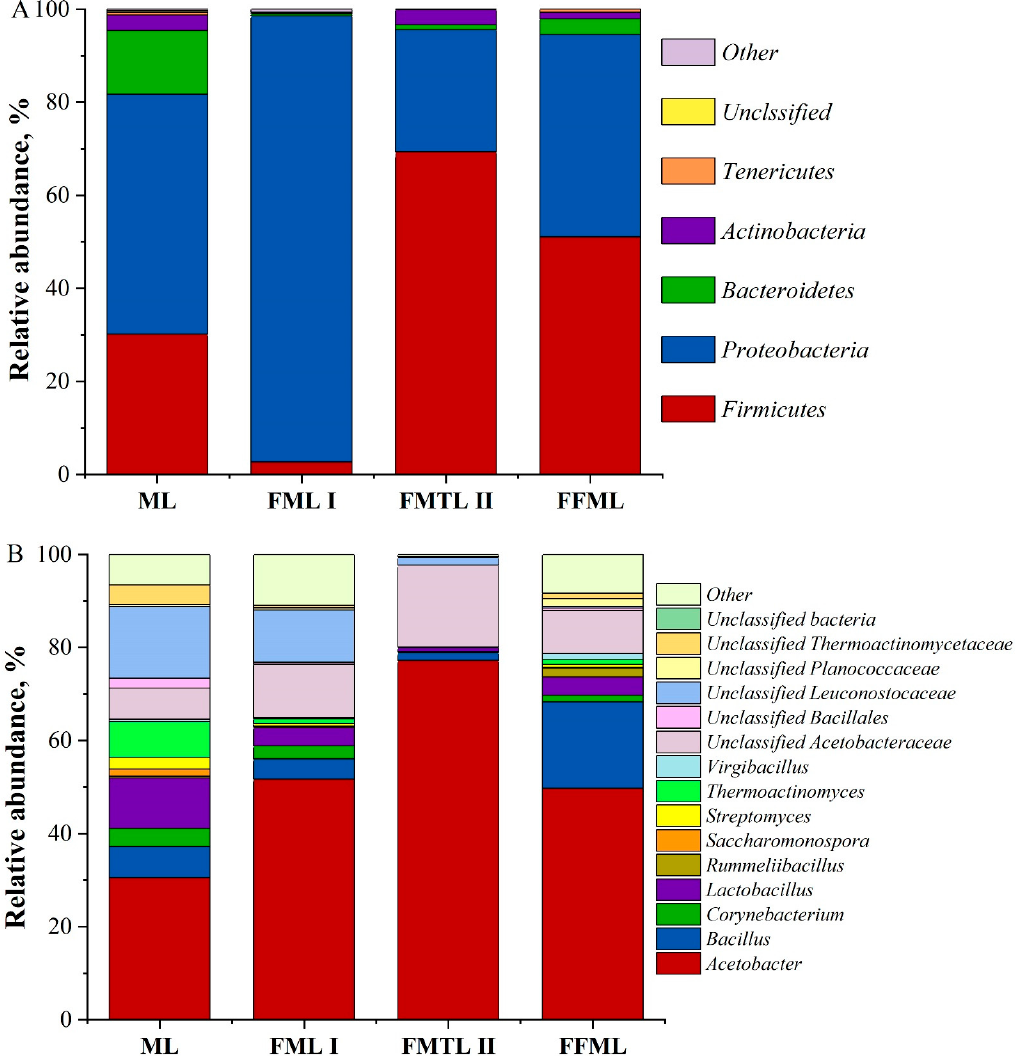
Figure 1. The bacterial composition of Mao-tai lees and fermented Mao-tai lees at the phylum ( A ) and genus ( B ) levels. ML, Mao-tai lees; FML, fermented Mao-tai lees; FML I, FML in the first stage; FML II, FML in the second stage; FFML, FML in the final stage. The bacterial composition of ML and FMLs at the genus level is shown in Figure 1B. The bacterial genera with less than 1.0% relative abundance were excluded from further analysis. Acetobacter (30.53–77.20%) and unclassified_Acetobacteraceae (6.69–17.56%) were